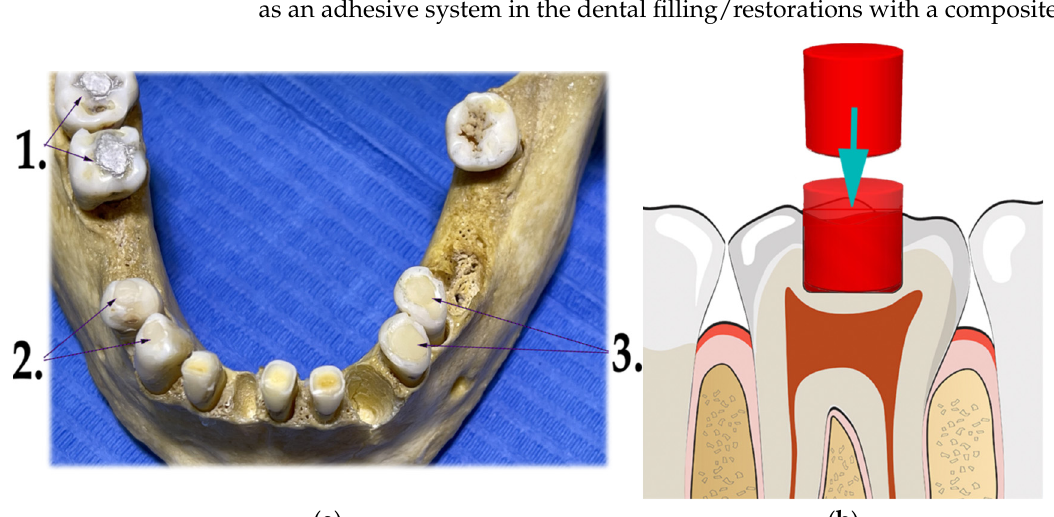
Figure 2. Dental fillings made on the teeth post-mortem. ( a ) Three dental materials were used in dental restorations: (1) amalgam extra-high copper non-gamma-two—Ana 2000 capsules, teeth 46 and 47; (2) glass ionomer—GC FUJI IX GP wear-resistant, teeth 43 and 44; (3) composite methacrylate resin—Neo Spectra ST (methacrylate-modified polysiloxane), teeth 34 and 35. ( b ) The filling was created with an occlusal part above the enamel surface with a horizontal plane with the intention to support the contact with the FTIR